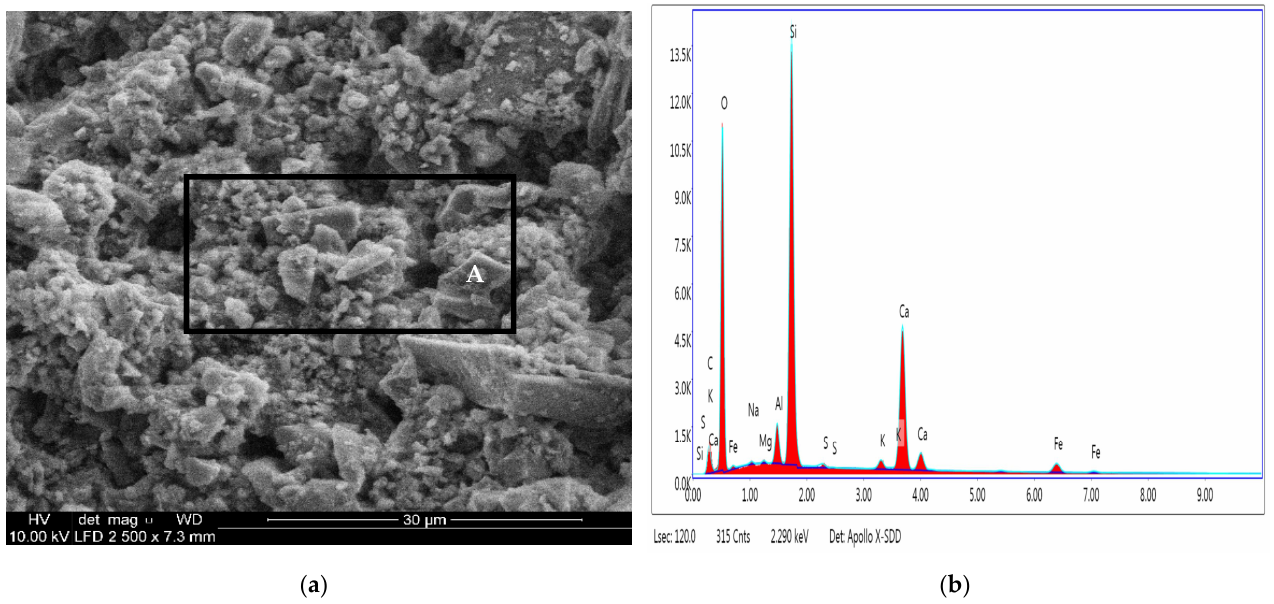
Figure 12. SEM/EXD analysis: ( a ) SEM microscopic images; ( b ) EDS of the sample on the selected area (A). Table 2. Element compositions of the sample determined via X-Ray EDS.